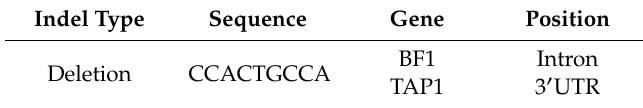
Table 9. Indel common to the high IgY groups or low IgY